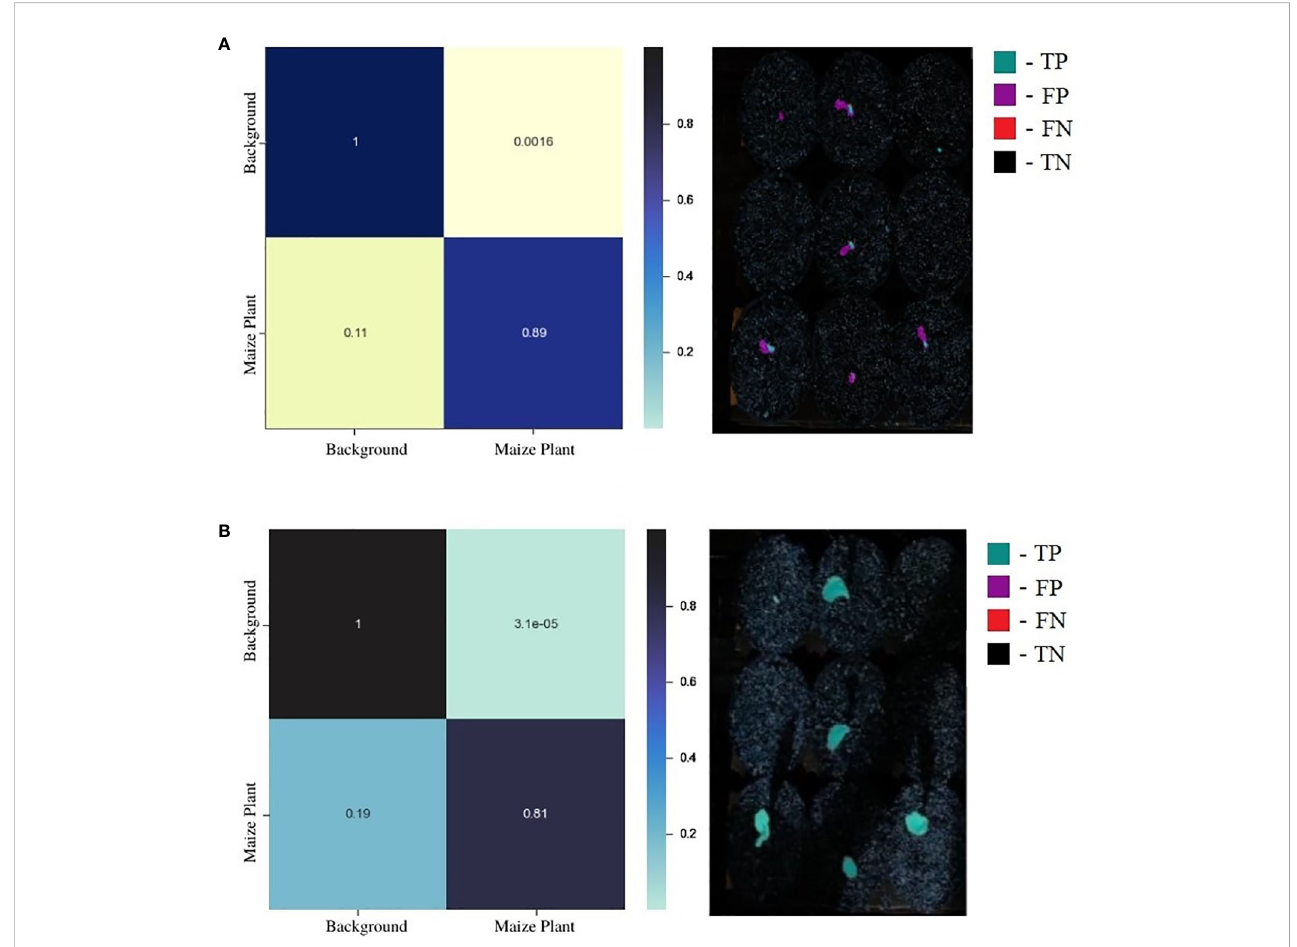
Figure 11C. Subsequently two more coleoptiles emerged, one in Figure 11D and the other in Figure 11G. Three seeds failed to emerge in the experiment. After their emergence, all six coleoptiles are correctly tracked. Thus, EmergeNet accurately identi fi es the emergence events and tracks the growth of the coleoptiles over time. We conducted an experiment to demonstrate the accuracy of the coleoptile size measured by the total number of constituent pixels of the generated masks by comparing them with the ground-truth. The result of thecomparisonisshowninFigure12.The fi gureshowsthecoleoptilesize of the generated mask (shown in blue) signi fi cantly overlaps with the coleoptile size of the ground-truth (shown in red). Thus, EmergeNet not only produces high-precision masks but also helps in the growth monitoring of coleoptiles with very high accuracy. Table 3 shows the Pearson correlation coef fi cient between the coleoptile size of the mask generated by EmergeNet and the ground-truth. Pearson correlation coef fi cient is a measure of the linear relationship between two